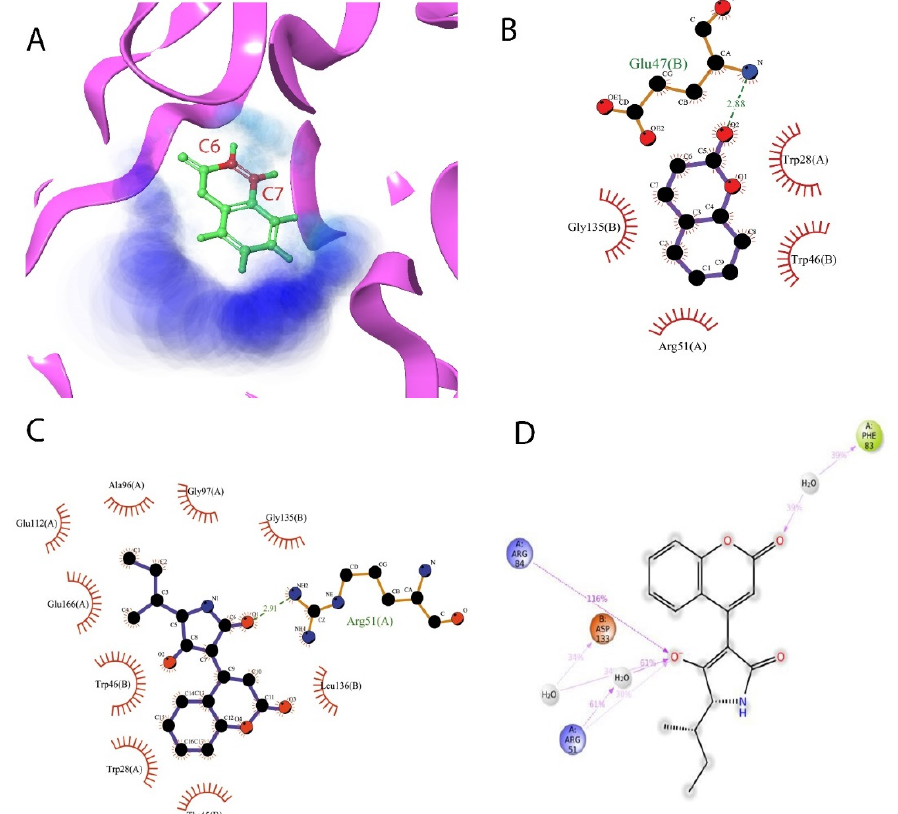
Figure 2. Enumeration and interaction profile of compounds with the receptor’s binding pocket. ( A ) The enumeration map of the binding pocket in the receptor is highlighted in magenta. Coumarin is colored in atom-specific colors: carbon in green, hydrogen in white, and oxygen in red. Dark blue is the site of solvent accessibility, and cyan is the site of the cavity. The atoms C6 and C7 are labeled in red and were utilized for enumeration. ( B ) Two-dimensional interaction profile of coumarin with residues in the binding site. ( C ) Two-dimensional interaction profile of principal compound with residues in the binding site. For both B and C, the hydrogen bond formed is shown in dashed green along with the bond length, and the hydrophobic interactions are highlighted in a shining red arch. ( D ) The 2D interaction profile of the principal compound shows the percentage of interaction with respective residues throughout the simulation period.